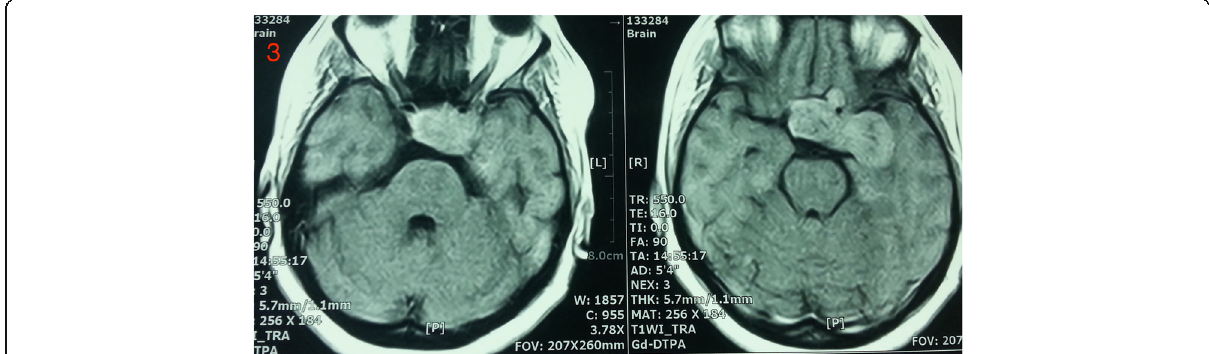
Fig. 3 MRI brain T1WI with contrast showing a case with significant lateral tumor